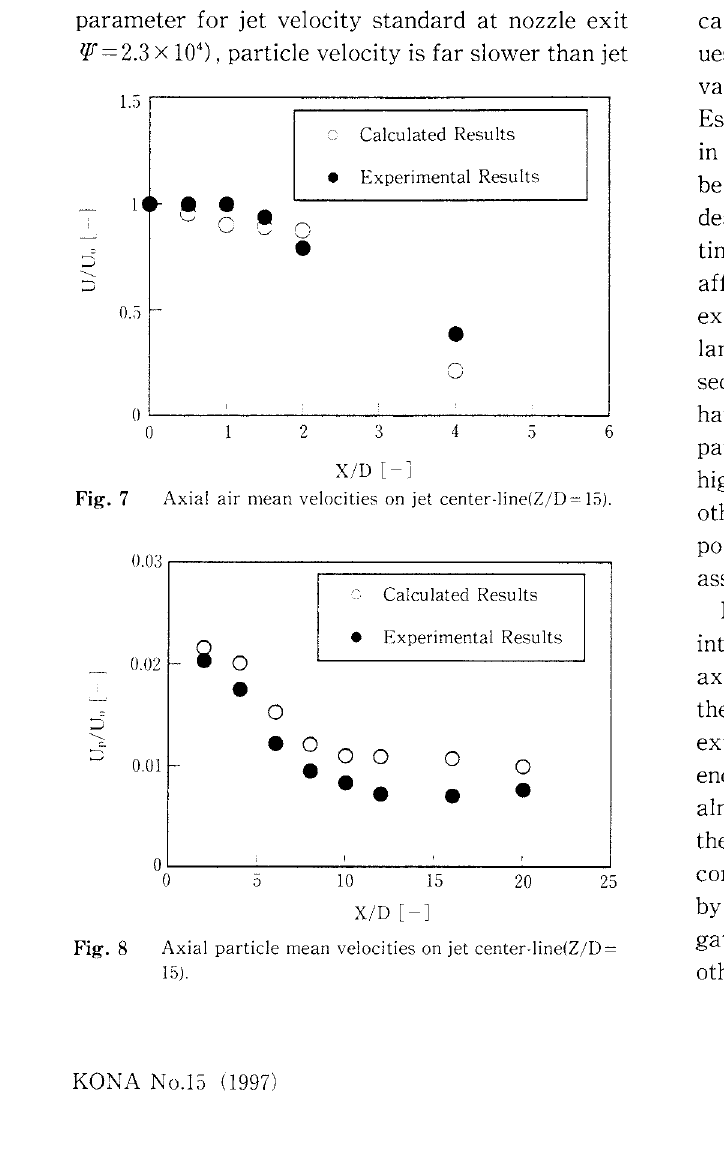
Axial particle mean velocities on jet center-line(Z/D=